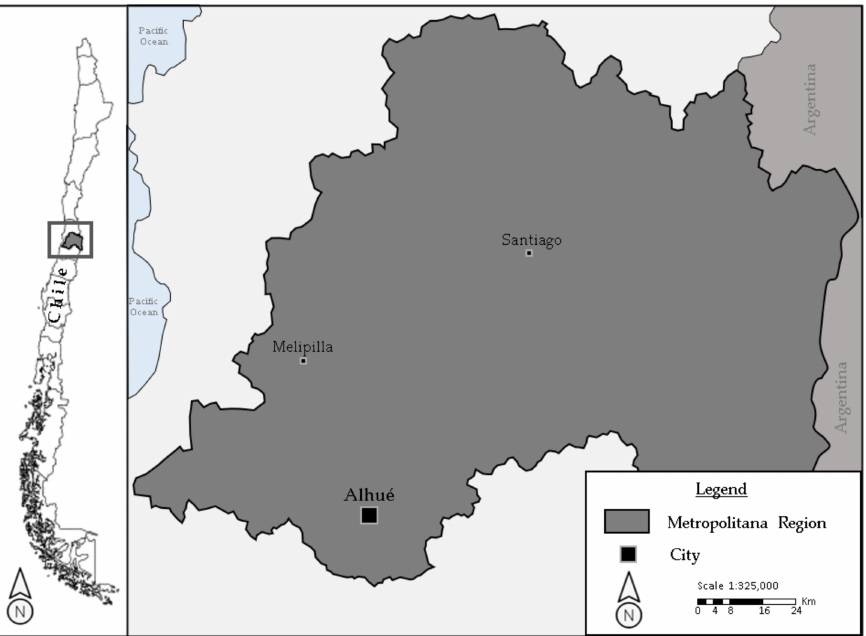
Figure 1. Location of the Alhu é mining district in relation to the Chilean capital